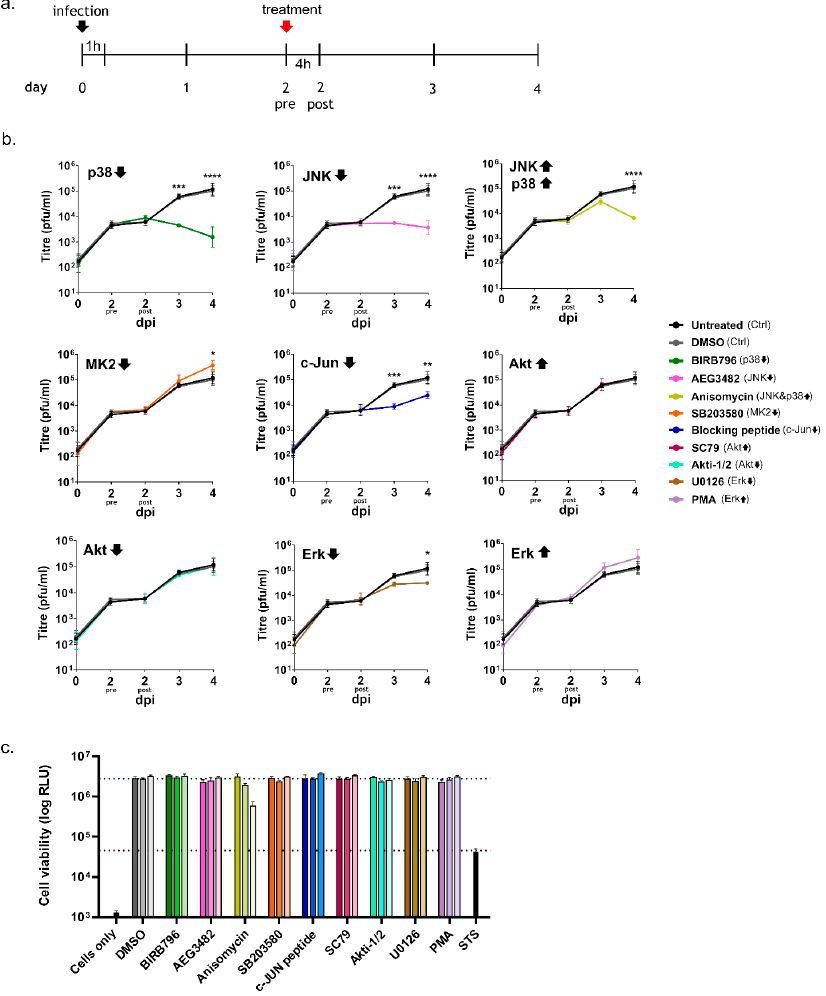
Figure 4. Influence of kinase inhibition or activation late in the infection on TCRV growth: ( a ) sche- matic timeline of the chemical treatment and infection procedure. The black arrow indicates the onset of the infection and the red arrow indicates the addition of drug dilutions on day 2 post infec- tion. Supernatants were harvested from day 0 to day 4 post infection. Samples were taken twice on day 2 post infection—before adding the drugs (2 pre) and 4 h after the treatment (2 post); ( b ) virus growth. Vero76 cells were infected at MOI = 0.1 and treated with the indicated chemical compounds according to the scheme shown in ( a ). Samples were collected on days 0, 2, 3 and 4 post infection for analysis by plaque assay. Specific inhibitors for p38 (BIRB796; green), MK2 (SB203580; orange), Akt (Akti-1/2; turquoise), JNK (AEG3482; pink), c-Jun (c-Jun blocking peptide; blue) and Erk (U0126; brown), as well as specific activators for p38 and JNK (Anisomycin; dark yellow), Akt (SC79;